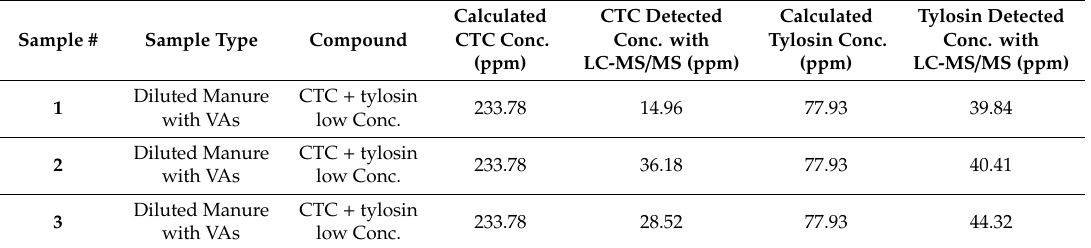
Table 9. Concentrations of VAs were detected in the manure external standard samples.